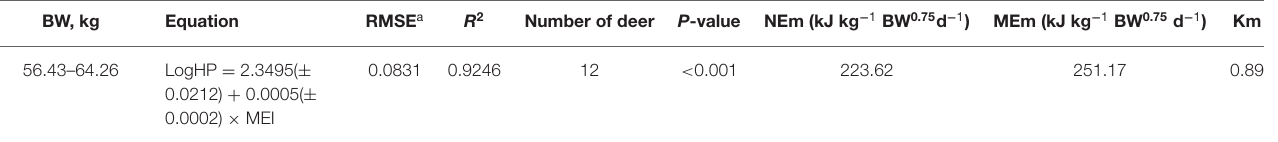
TABLE 6 | Estimates of heat production (HP, kJ kg − 1 BW 0.75 d − 1 ) and metabolisable energy (ME) intake (MEI, kJ kg − 1 BW 0.75 d − 1 ) in the equation to predict net energy requirement for maintenance of sika deer.